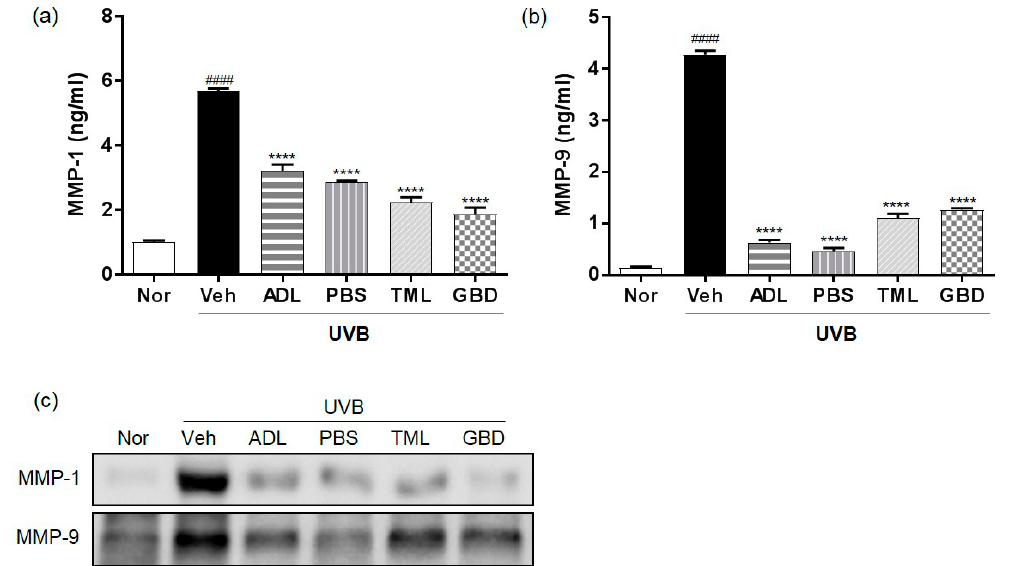
Figure 3. Effect of insect extracts on matrix metalloproteinase (MMP) and procollagen expression. ( a ) MMP-1 and ( b ) MMP-9 protein levels in UVB-irradiated skin. ( c ) Western blot analysis of effects of insect extracts on UVB-mediated induction of MMP-1 and MMP-9. #### p < 0.0001 vs. normal group, **** p < 0.0001 vs. vehicle group. These measurements were performed in triplicate. Nor, Normal; Veh, Vehicle; ADL, Allomyrina dichotoma larva; PBS, Protaetia brevitarsis seulensis ; TML, Tenebrio molitor Linnaeus; GBD, Gryllus bimaculatus De Geer.